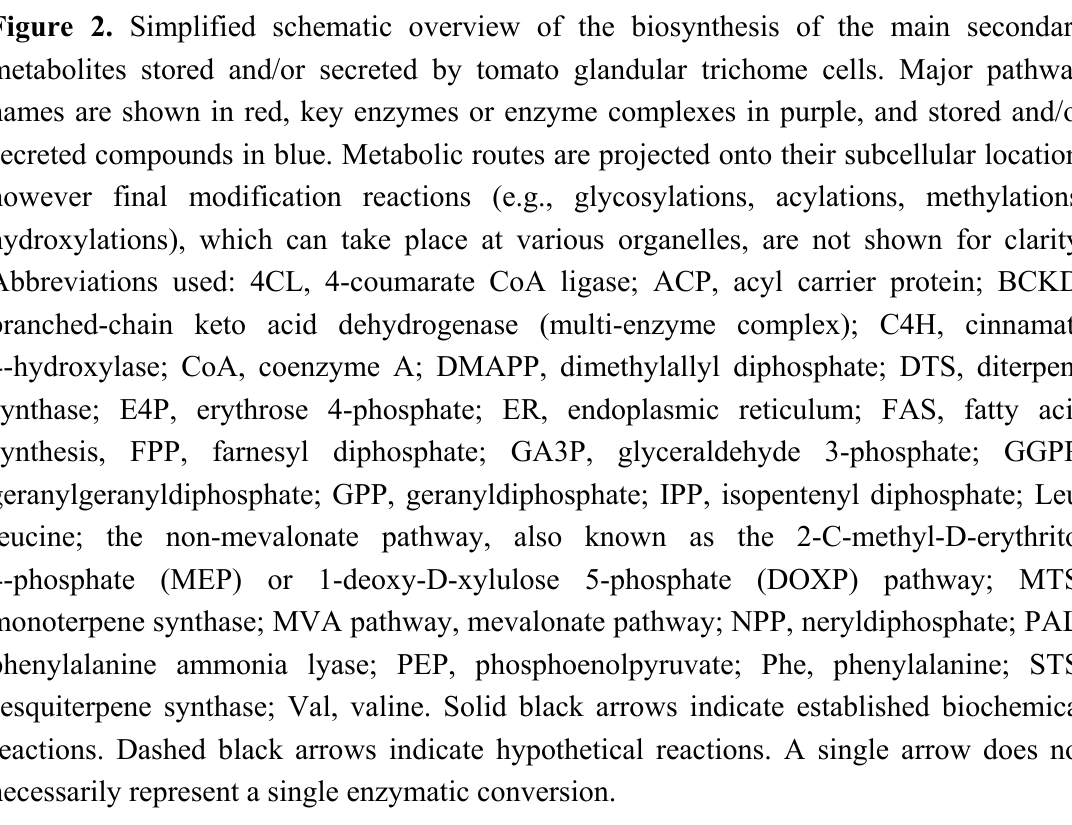
Figure 2. Simplified schematic overview of the biosynthesis of the main secondary metabolites stored and/or secreted by tomato glandular trichome cells. Major pathway names are shown in red, key enzymes or enzyme complexes in purple, and stored and/or secreted compounds in blue. Metabolic routes are projected onto their subcellular location, however final modification reactions (e.g., glycosylations, acylations, methylations, hydroxylations), which can take place at various organelles, are not shown for